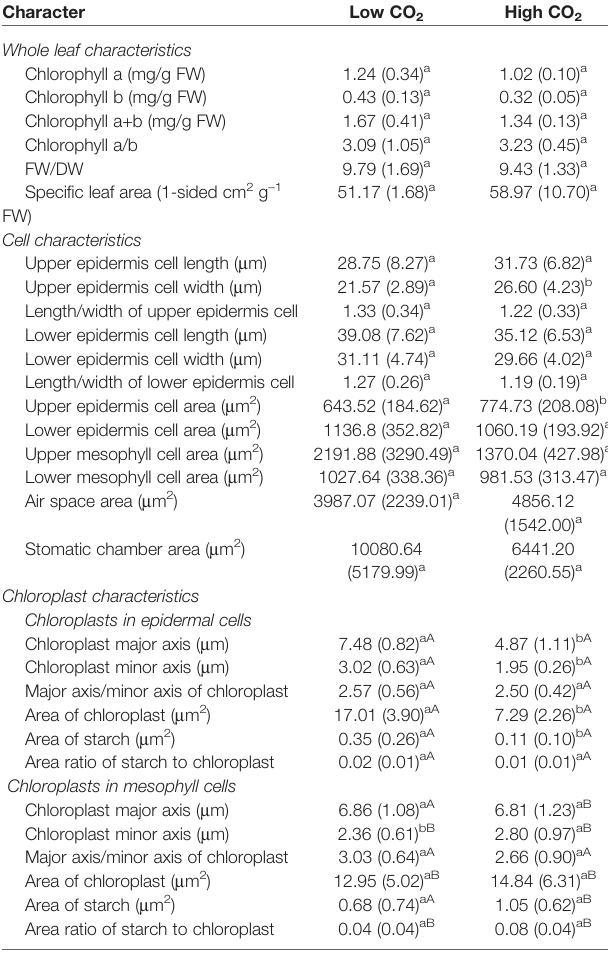
TABLE 2 | Effects of low and high CO 2 concentrations on the morphological and anatomical characteristics of the O. cordata fl oating leaves.